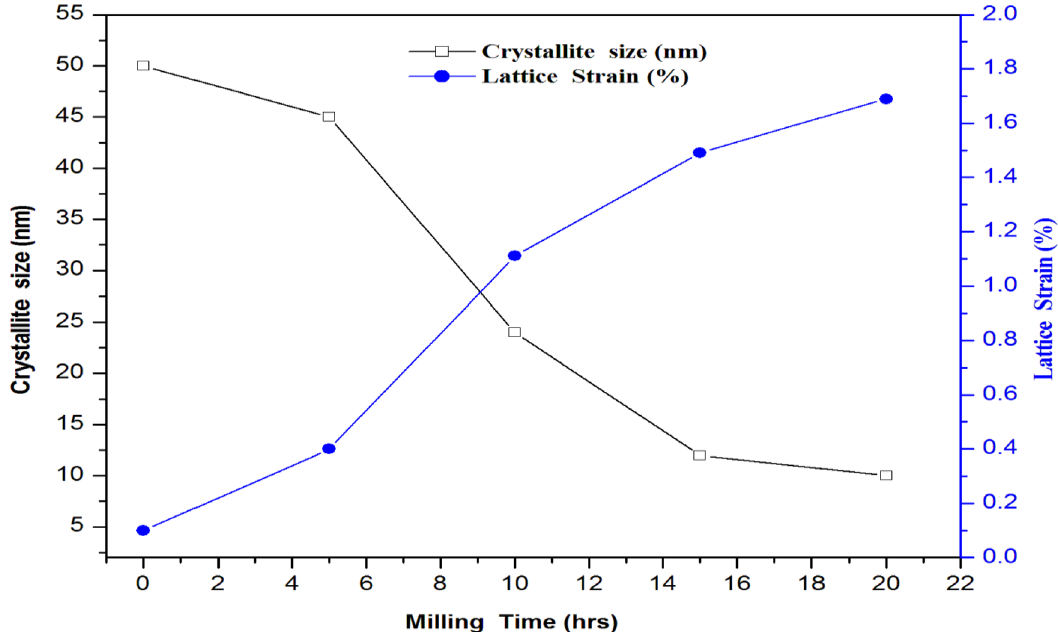
Fig. 6. Crystallite size and Lattice strain concerning different milling times at 300